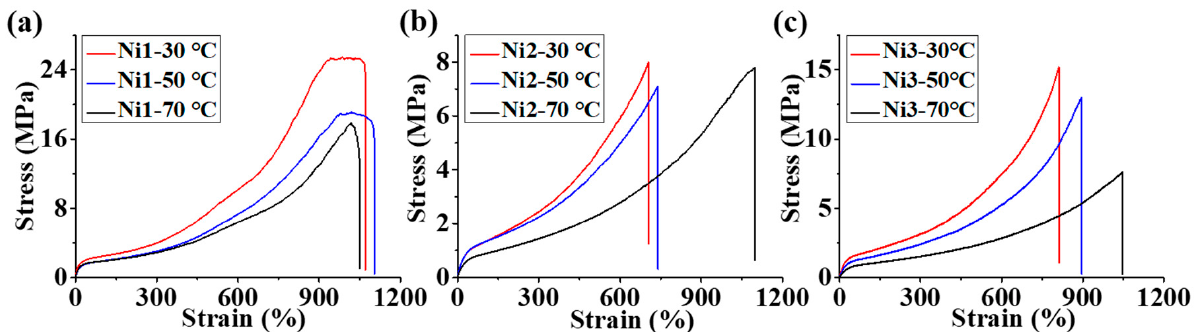
Figure 4. The comparisons of stress–strain curves for polyethylene samples produced by Ni1-3 at different temperatures ( a – c ).